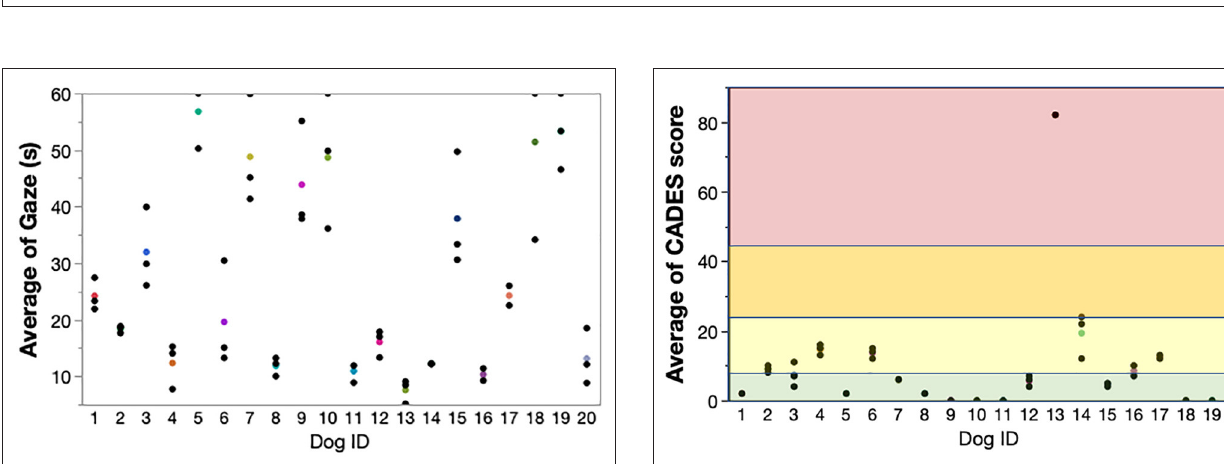
FIGURE 2 | (A) There is a significant relationship between CADES score and sustained gaze duration ( r 2 : 0.16, p = 0.0026). (B) When the outlier values from the severely affected dog are excluded, there is a significant relationship between CADES score and sustained gaze duration ( r 2 : 0.21, p = 0.0005). CADES: CAnine DEmentia Scale; s: seconds.